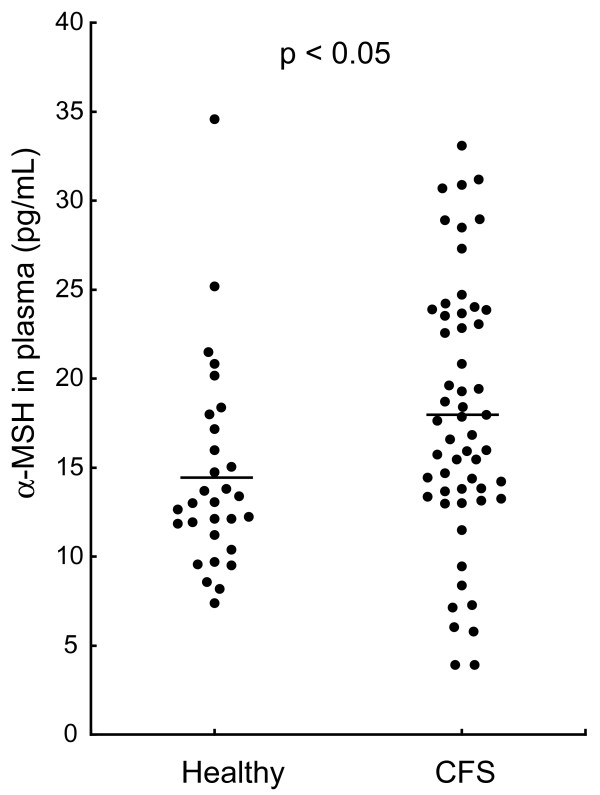
Concentrations of α-MSH in plasma of healthy control and CFS patients. α-MSH levels in CFS patients were significantly higher than in healthy controls (p < 0.05). The range of values in the CFS group was wider than that in the control group.